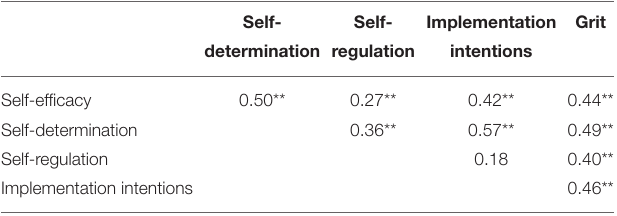
TABLE 4 | Correlations of teacher leader identity attributes composite scores ( n =